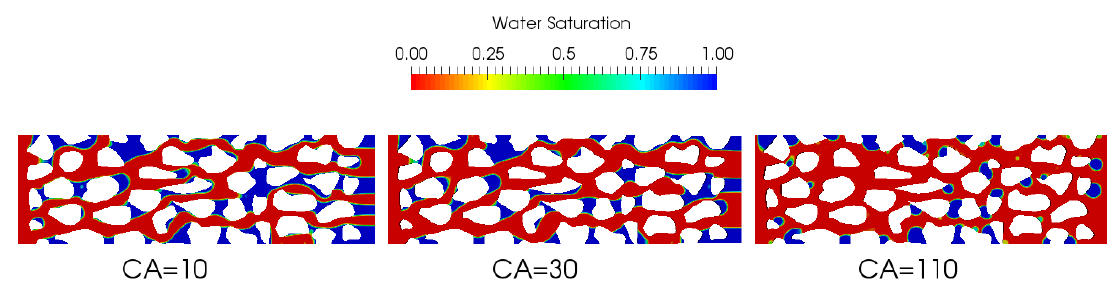
Figure 8. Effect of contact angle on water